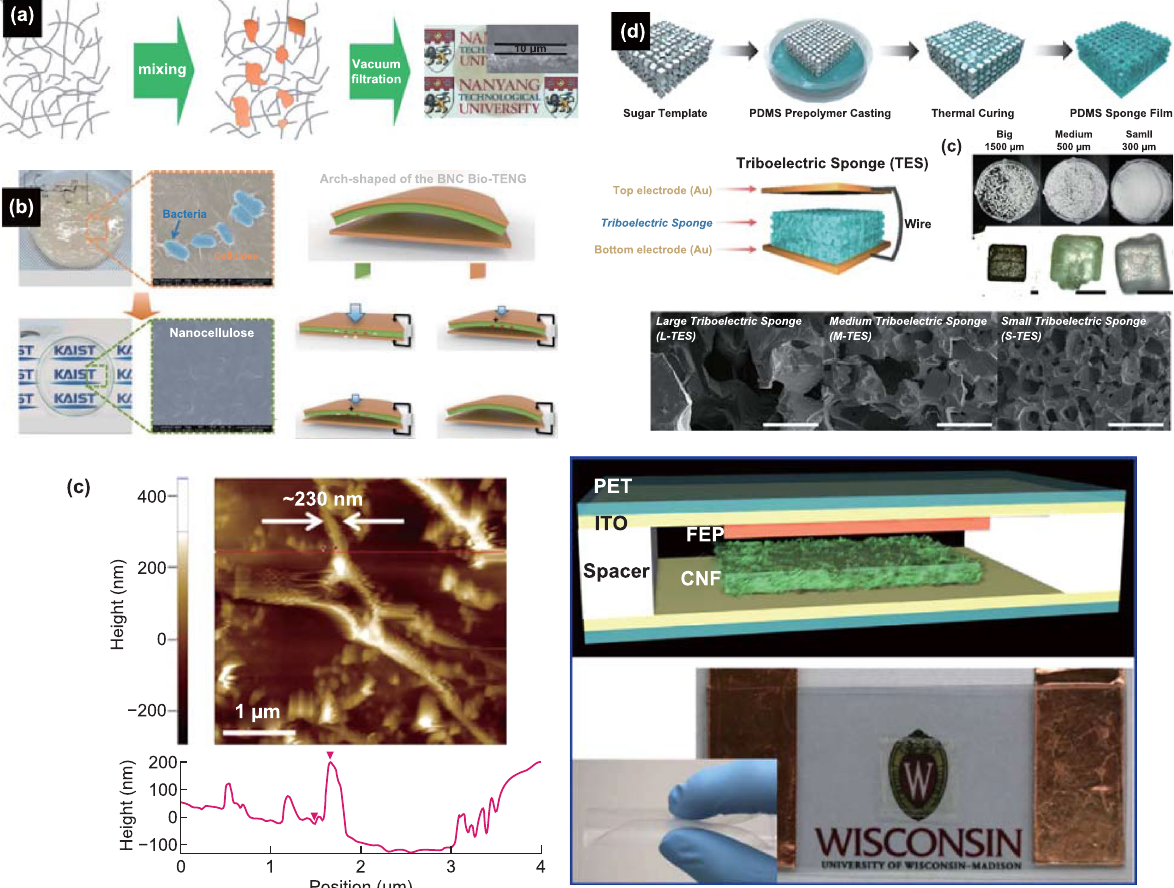
Fig. 3 Products of processing of plants used to design TENGs: a cellulose/phosphorene hybrid TENG preparation and transparency demonstra‑ tion. Reprinted with permission from Ref. [72]. Copyright (2017) Wiley‑VCH Verlag GmbH & Co. KGaA, Weinheim. b Demonstration of a bacterial nanocellulose‑based TENG. Reprinted with permission from Ref. [78]. Copyright (2017) Published by Elsevier Ltd. c Surface struc‑ ture, schematic illustration and demonstration of the transparency of a TENG based on cellulose nanofibrils. Reprinted with permission from Ref. [82]. Copyright (2016) Published by Elsevier Ltd. d Sponge TENG fabricated by 3D soft lithography using sugar particles. Reprinted with permission from Ref. [86]. Copyright (2016) Wiley‑VCH Verlag GmbH & Co. KGaA,